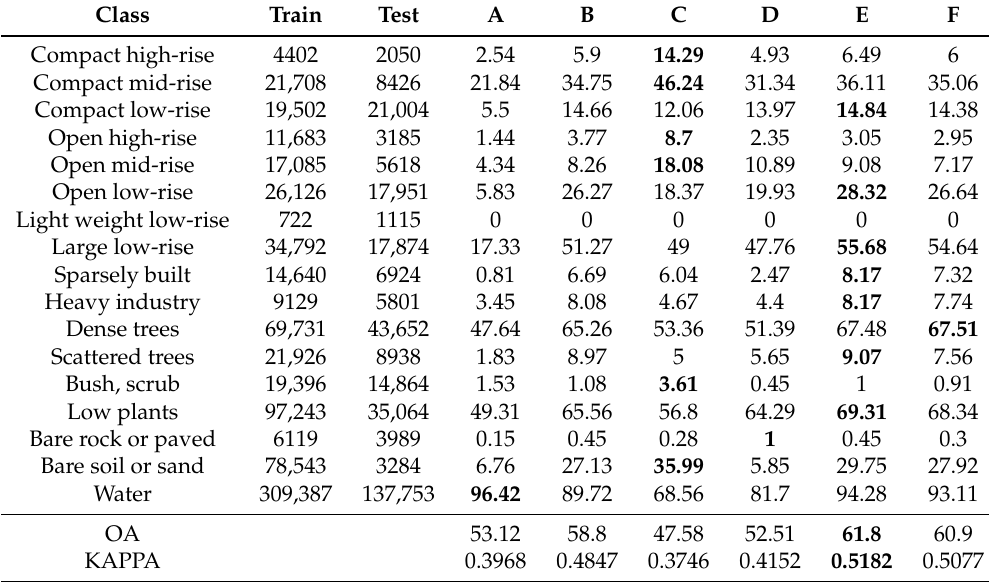
Table 4. The producer accuracies, OA, and kappa coefficient of the CCF classification approach on different feature combinations (as detailed in Table 5). The number of training and test samples are listed for different classes. The best accuracy for each class is shown in a bold typeface. The metric OA and class-specific accuracy are reported in percentages, and the Kappa coefficient is